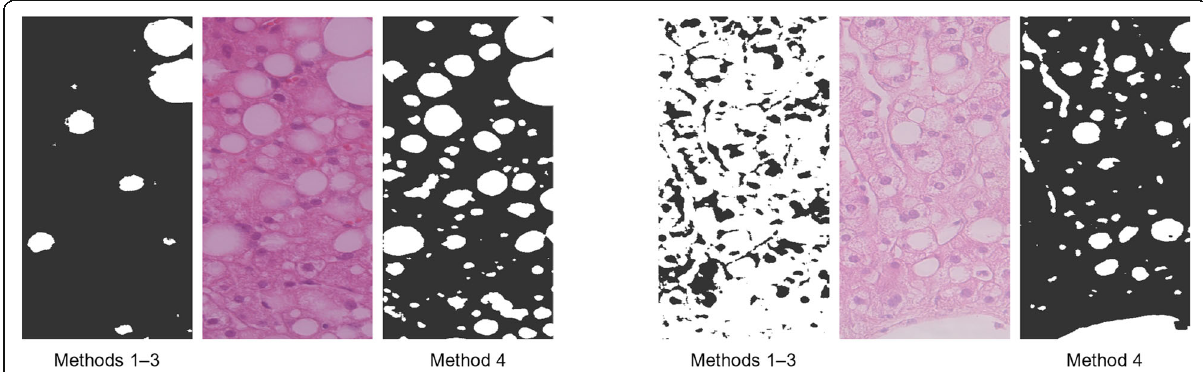
Fig. 4 Robustness to image variability. Method 4 incorporates a new pixel classification approach to improve the robustness to image